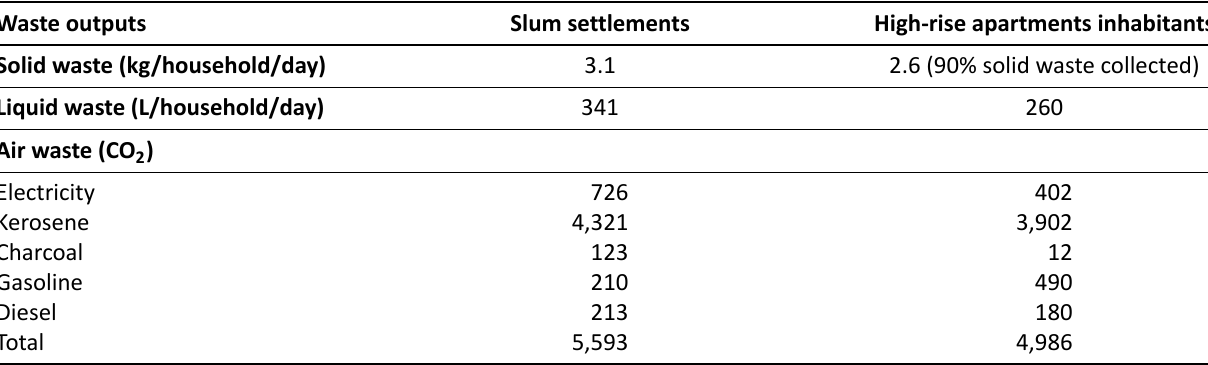
Table 5. Waste outputs to Arat Kilo slum settlement and high-rise apartments, Addis Ababa, Ethiopia. Source: Authors’ filed data.